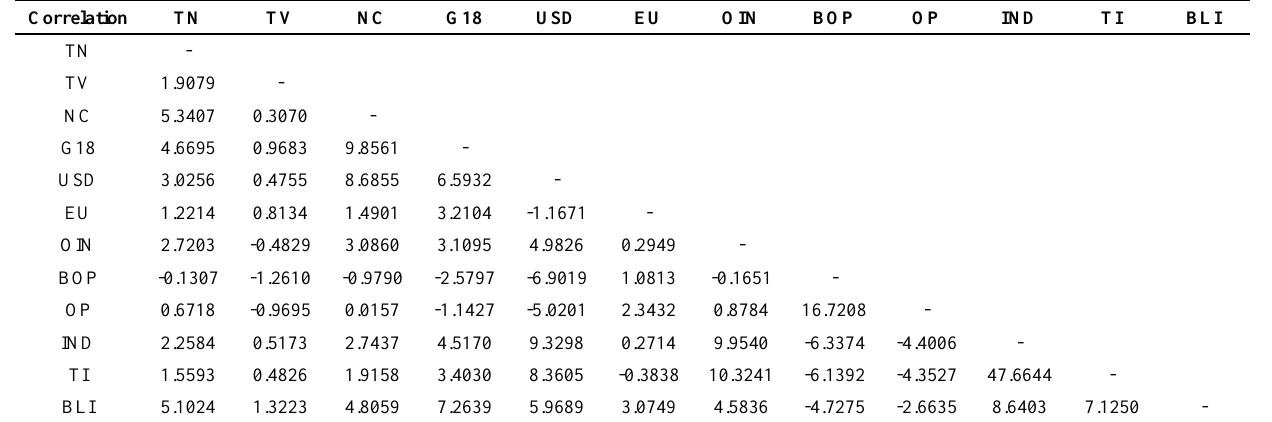
Table 4. T-Stats for correlation between candidate